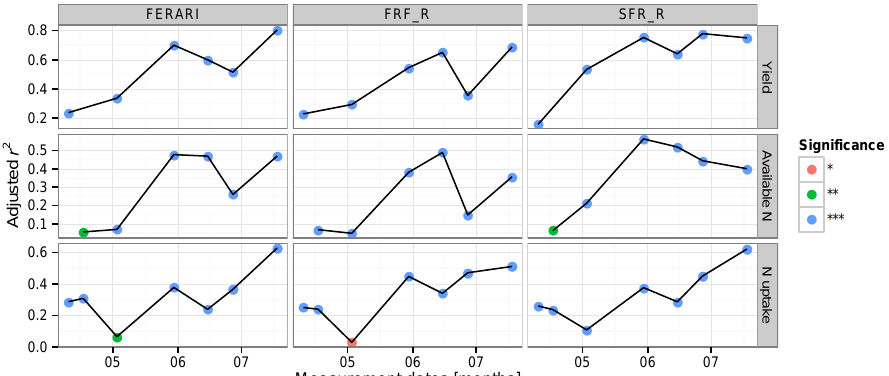
Figure 7. Adjusted r 2 values for indices of Multiplex Research ™ fluorescence sensor over the 2012 measurement period. The colour expresses the different significance levels: *** p -value < 0.001; ** p -value < 0.01; * p -value <